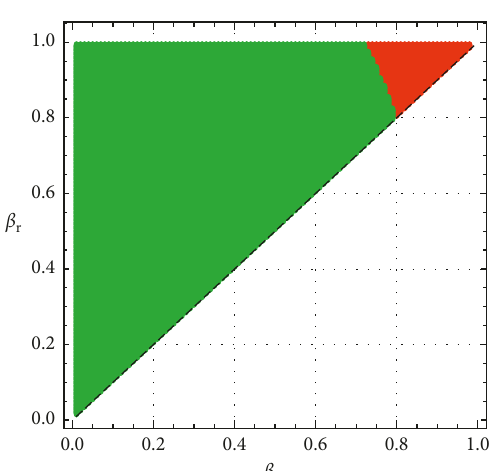
Figure 11: Comparison of steady-state profits with β � 12. θ 0